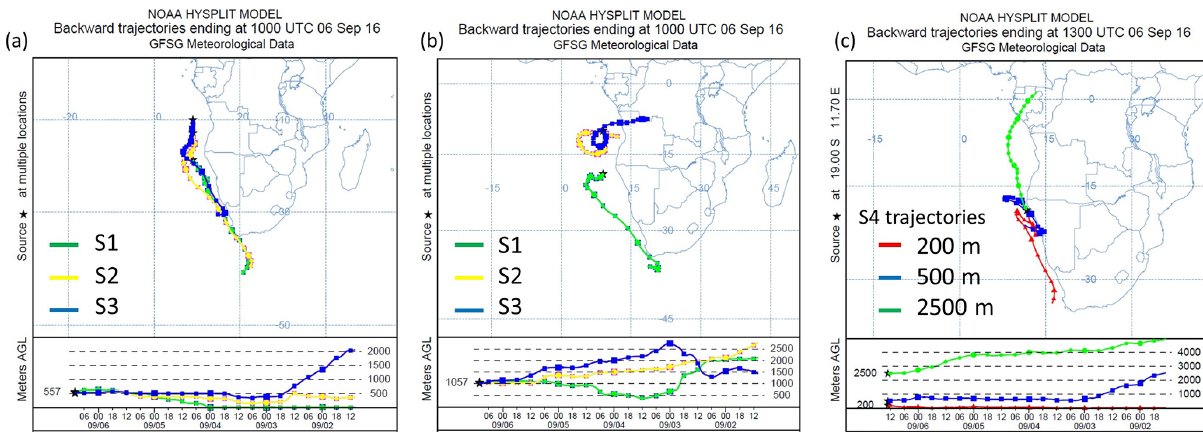
Figure 5. Five-day back trajectories from the Hybrid Single-Particle Lagrangian Integrated Trajectory model for sawtooth maneuvers flown on 6 September 2016 (a) ending at 10:00UTC for S1–S3 at 500ma . m . s . l . ; (b) ending at 10:00UTC for S1–S3 at 1000ma . m . s . l . ; and (c) ending at 13:00UTC for S4 at 200, 500, and 2500ma . m . s . l.